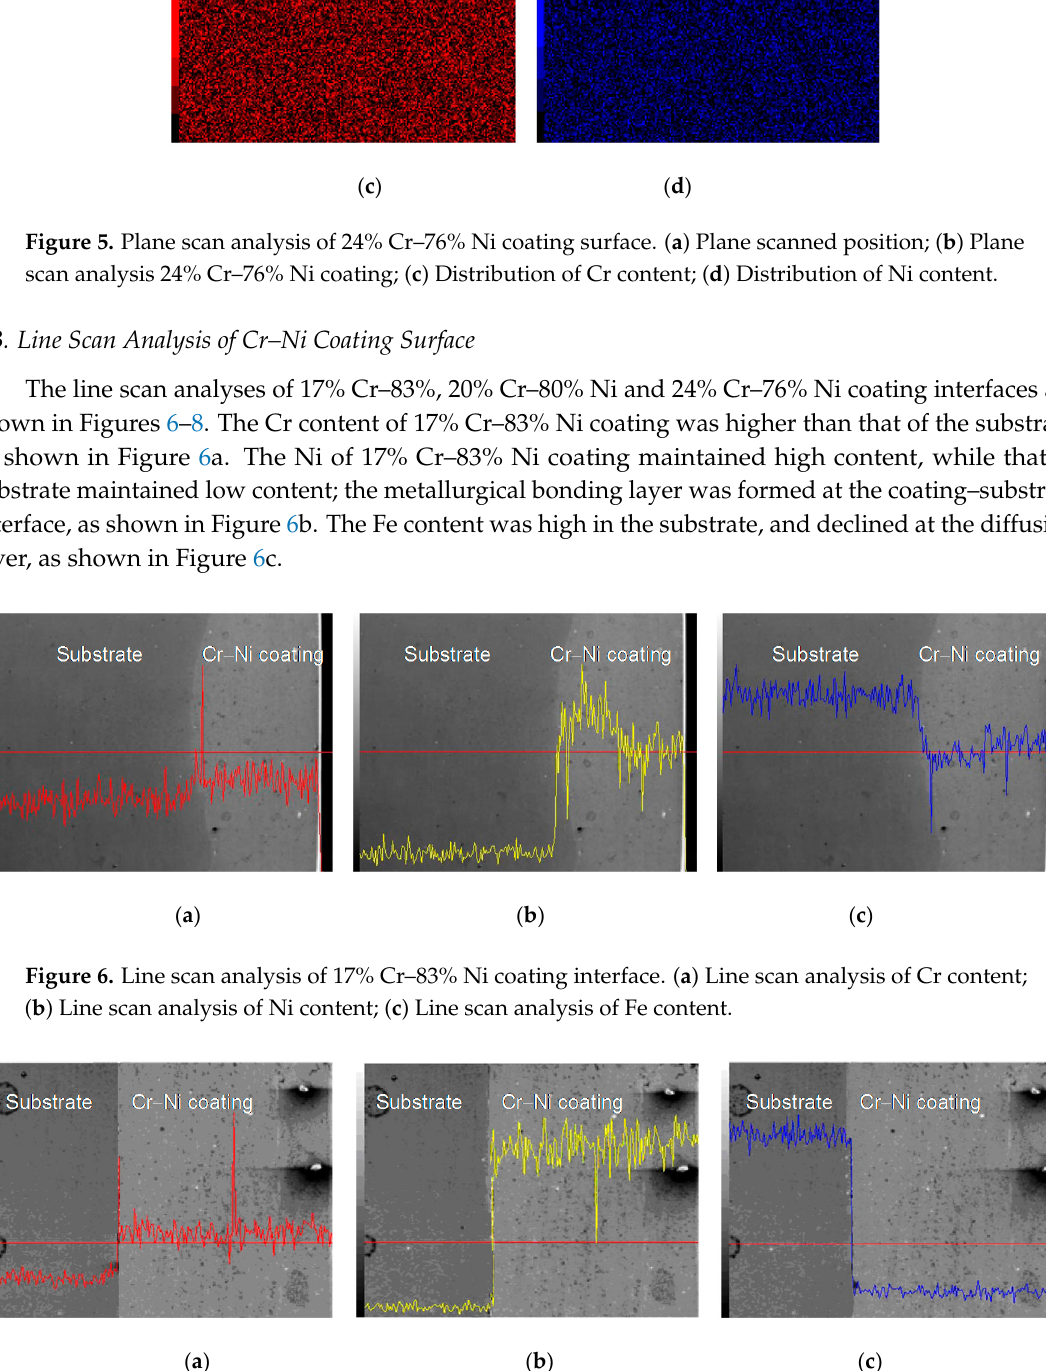
( b ) Line scan analysis of Ni content; ( c ) Line scan analysis of Fe content.